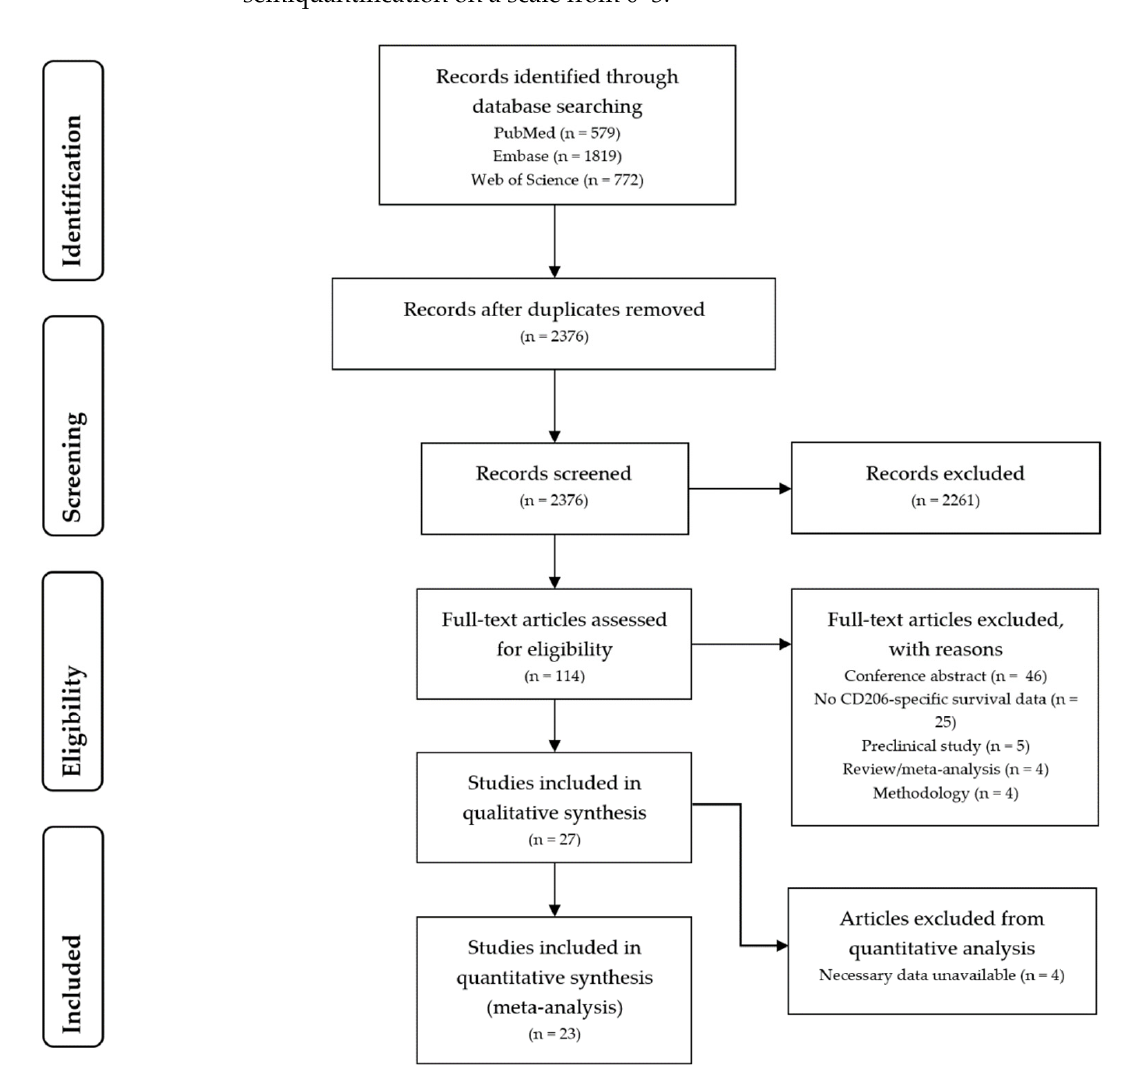
Figure 1. Flow diagram of literature search and selection.